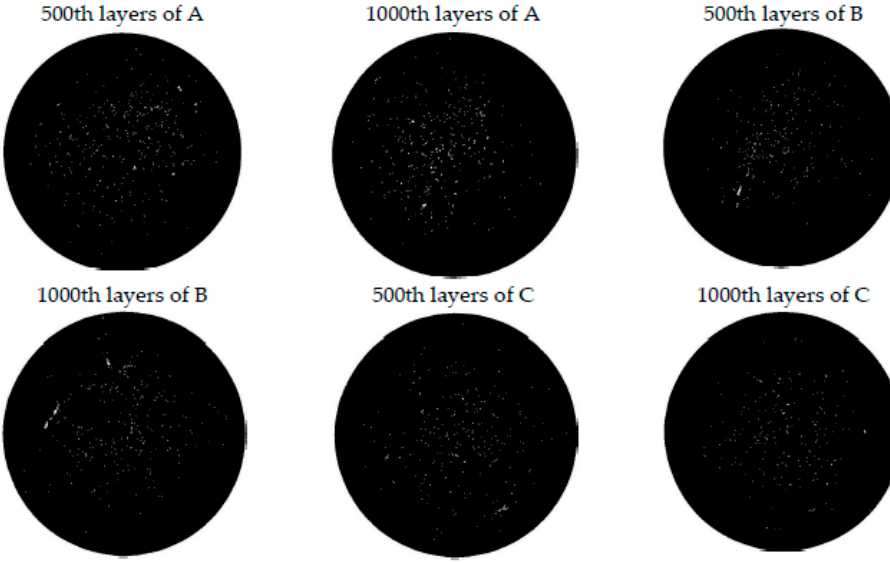
Figure 13. Oil shale CT-scan imaging after the binarization processing.